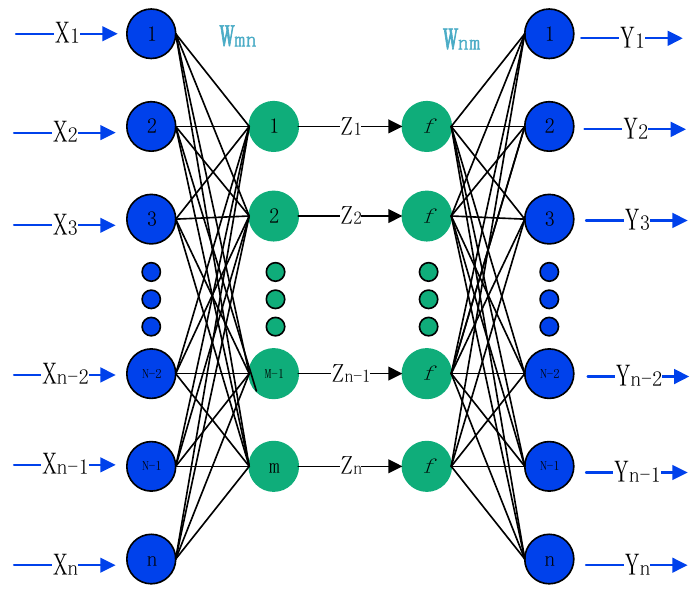
Figure 7. Topological graph of the autoencoder.